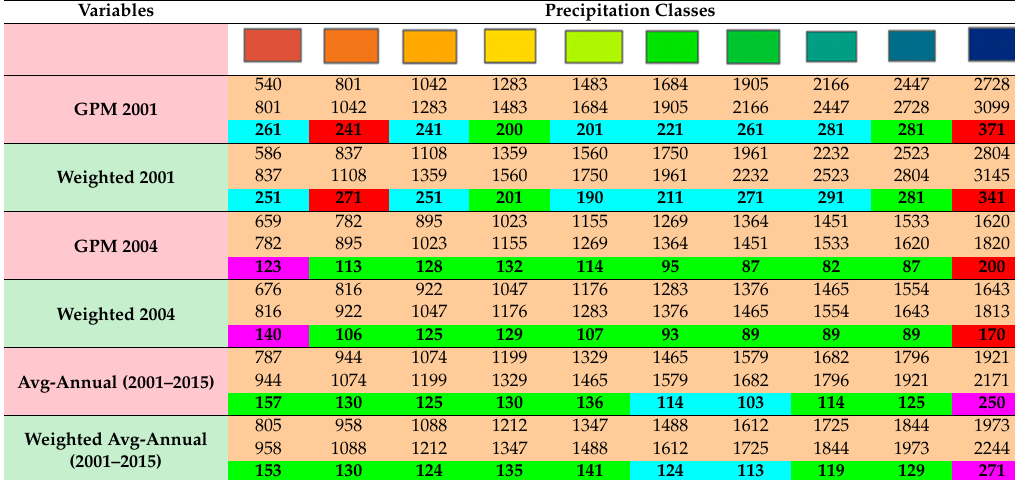
Table 6. Comparison of spatial pattern between GPM based precipitations with its corresponding Table 6. The comparison of spatial pattern between the GPM-based precipitation with its Table 6. The comparison of spatial pattern between the GPM-based precipitation with its Table 6. The comparison of spatial pattern between the GPM-based precipitation with its Table 6. The comparison of spatial pattern between the GPM-based precipitation with its Table 6. The comparison of spatial pattern between the GPM-based precipitation with its Table 6. The comparison of spatial pattern between the GPM-based precipitation with its Table 6. The comparison of spatial pattern between the GPM-based precipitation with its Table 6. The comparison of spatial pattern between the GPM-based precipitation with its weighted precipitation for di ff erent precipitation classes. corresponding weighted precipitation for different precipitation classes. corresponding weighted precipitation for different precipitation classes. corresponding weighted precipitation for different precipitation classes. corresponding weighted precipitation for different precipitation classes. corresponding weighted precipitation for different precipitation classes. corresponding weighted precipitation for different precipitation classes. corresponding weighted precipitation for different precipitation classes.